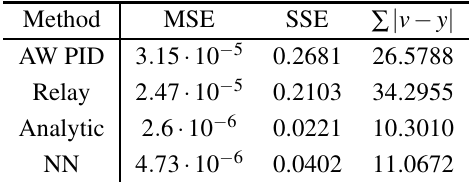
Table 4. Statistical measure of performance in steady-state.